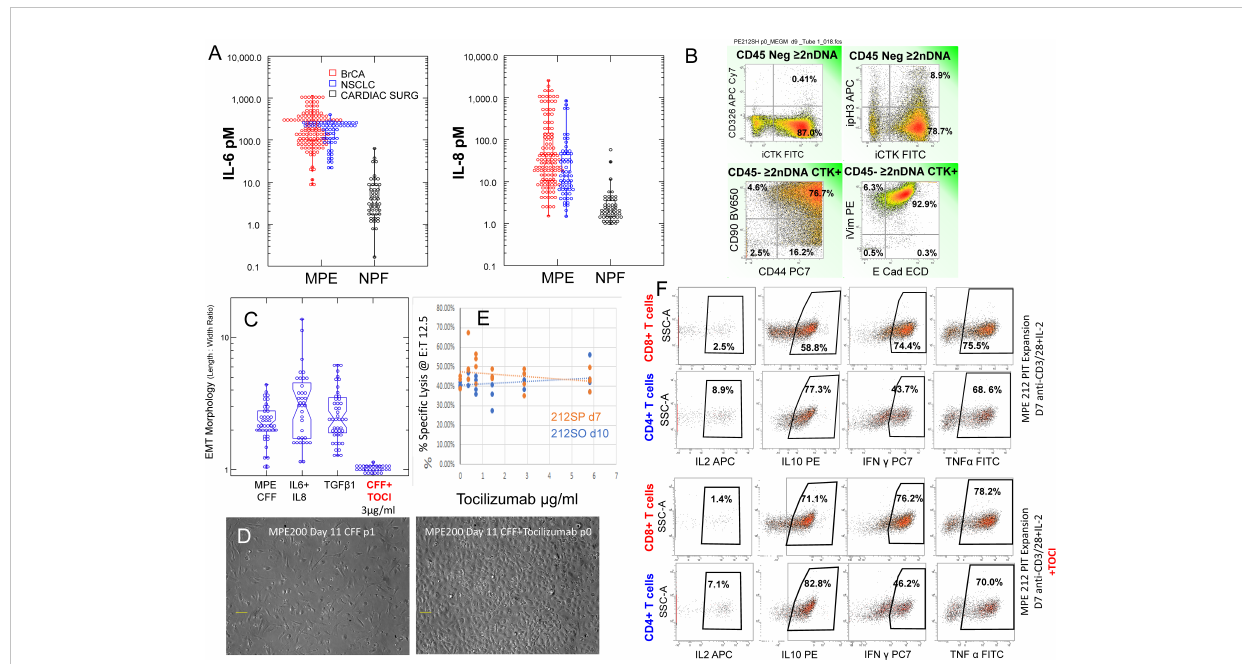
FIGURE 5 Effects of Tocilizumab on tumor EMT, antitumor cytotoxic effector function and cytokine secretion. (A) IL-6 and IL-8 levels in MPE fl uid from Breast cancer (red circles, all subtypes, n = 122) and non-small cell lung cancer (blue circles, n = 61) compared to normal pleural fl uid isolated from patients undergoing cardiac surgery (black circles). (B) Flow cytometry on passage 0 MPE tumor cells. Histograms are gated in CD45 negative aneuploid (>2N DNA content) cells. The majority of cytokeratin+ cells have lost surface expression of CD326 (EpCAM), coexpress CD90, CD44, vimentin and E-cadherin, indicating pEMT. 10.2% of cytokeratin+ tumor cells are in cycle as indicated by histone H3 phosphorylation (pH3). (C, D) The majority of MPE tumor cells cultured in the presence of autologous cell free fl uid (CFF) or medium supplemented with IL-6, IL-8 or TGF b demonstrate a fi broblastoid morphology quanti fi ed by the length to width ratio (left panel). Addition of tocilizumab (3µg/mL) to cultures containing CFF blocked EMT, causing cells to transition to epithelioid morphology (D) right panel. (E) Pleural T cells, activated and expanded in the presence of CD3/CD28 beads plus IL-2 are potent cytotoxic effectors against autologous tumor as measured by LDH release at a fi xed effector to target ratio of 12.5: 1. Addition of graded doses of tocilizumab during activation and expansion did not alter cytotoxic activity. (F) The same cells that were tested for cytolytic activity (D) were evaluated for cytokine production by fl ow cytometry with (pooled 3 and 6 m g/mL) and without tocilizumab. Activated CD4 and CD8 pleural T cells actively produced IL-10, IFN g and TNF a . Cytokine production was not affected by inclusion of tocilizumab during activation.